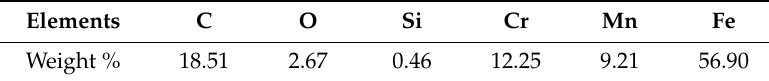
Figure 18 EDS/SEM spectrum analysis of fracture face of ATIG weld zone. Table 12. Elements present in fracture face of ATIG weld zone. Table 12. Elements present in fracture face of ATIG weld